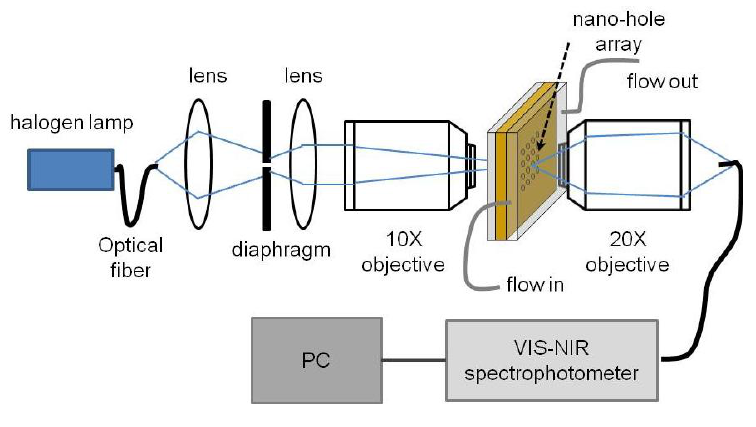
Figure 4. Scheme of the optical setup to measure the transmission spectra through the fabricated nanohole